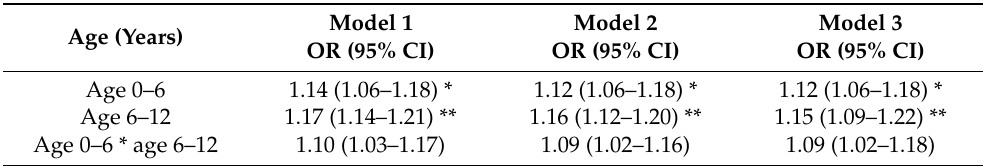
Figure 3. Association between FD exposure and (pre)frailty. Table 2. Association of hunger at different age groups with